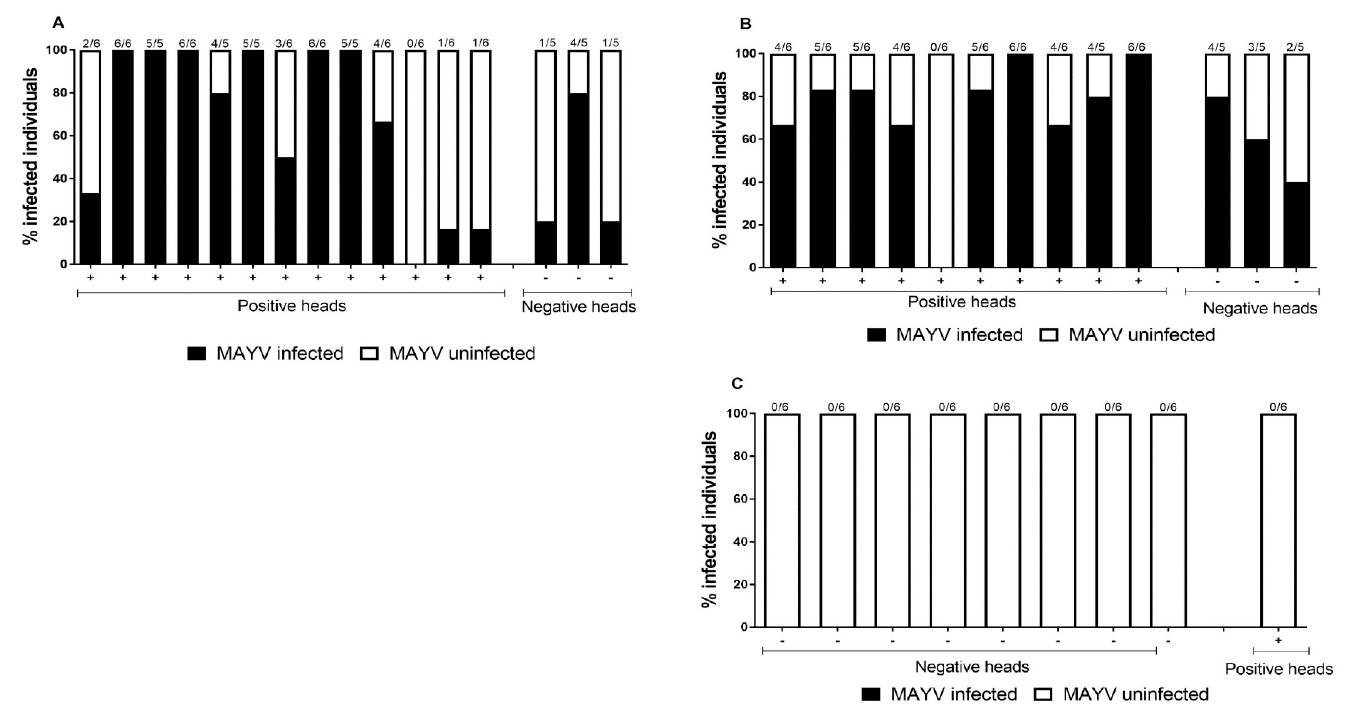
Fig 2. Nanoinjection of saliva from three infected mosquito species into na ï ve Aedes aegypti mosquitoes. Saliva samples were collected from Aedes aegypti (A), Aedes albopictus (B), and Culex quinquefasciatus (C), which were previously infected with MAYV (at 14 dpi), followed by injection into na ï ve mosquitoes. Mosquitoes that became infected are shown in black and uninfected are depicted in white. Each bar represents a single saliva sample, and the number of transmission rate mosquitoes nanoinjected mosquitoes is given at the top of each